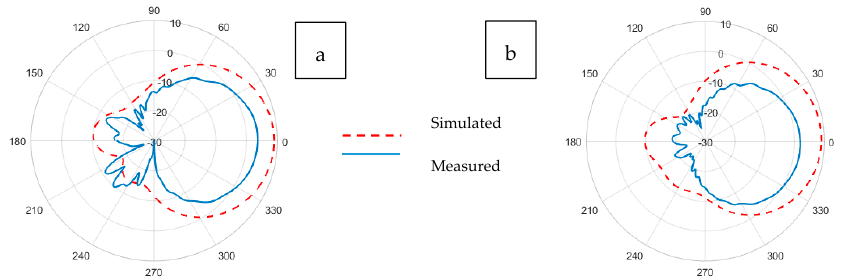
Figure 14. Simulated and experimental ( a ) E-plane and ( b ) H-plane radiation patterns of Kiel-SK-96-based perforated RRMPA at 2.45 GHz.